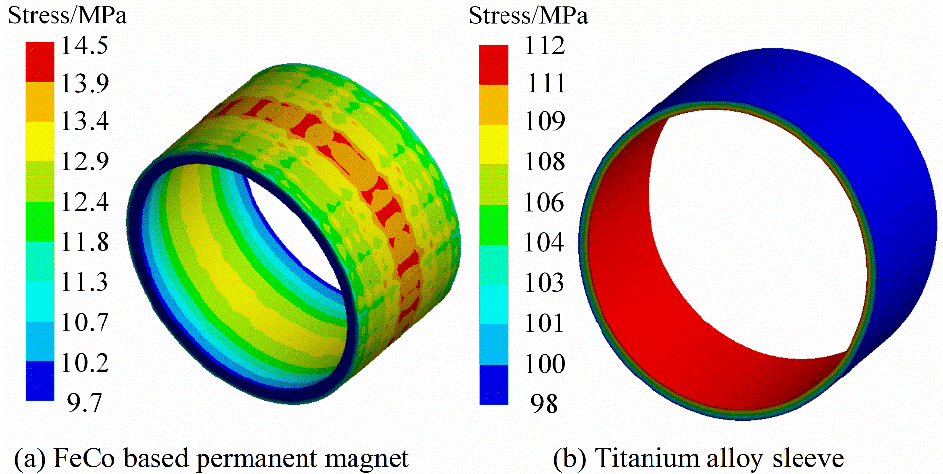
Figure 7. Von-Mises stress distribution of FeCo-based PM and sleeve under cold rotating condition.